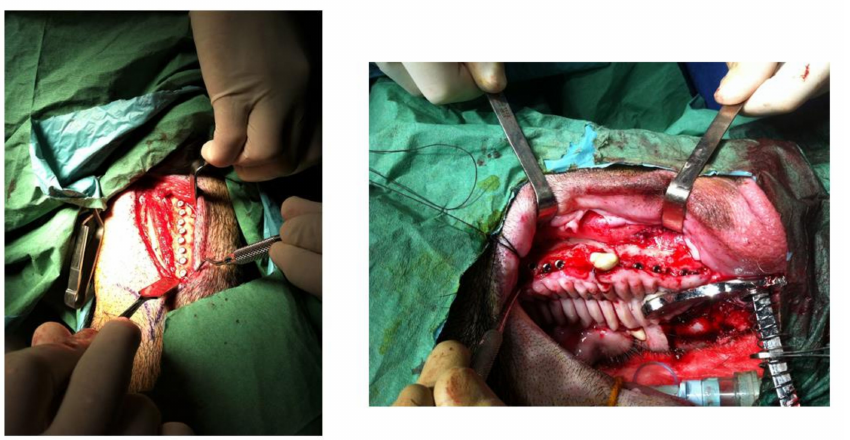
Figure 2. Insertion of the dental implants in the mandibular